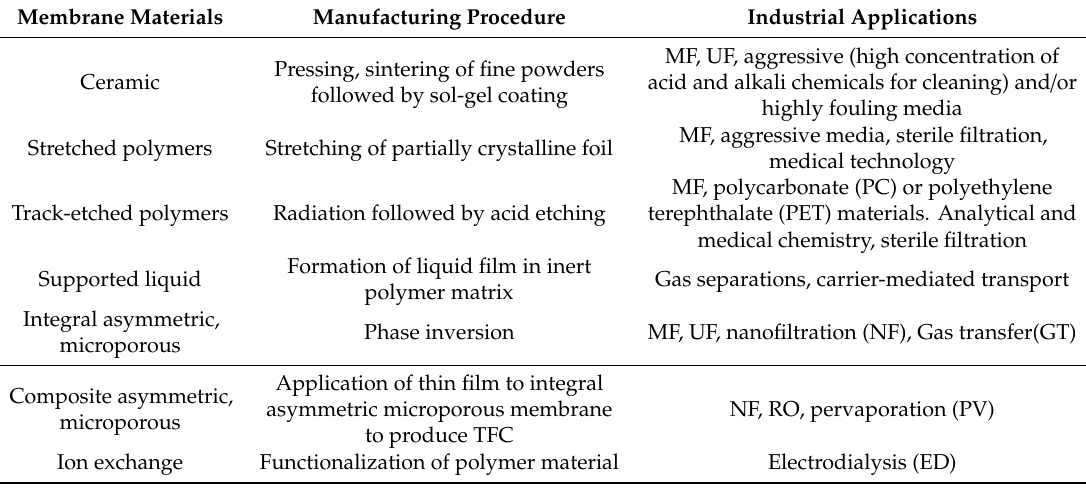
Table 3. Membrane manufacturing procedures and applications